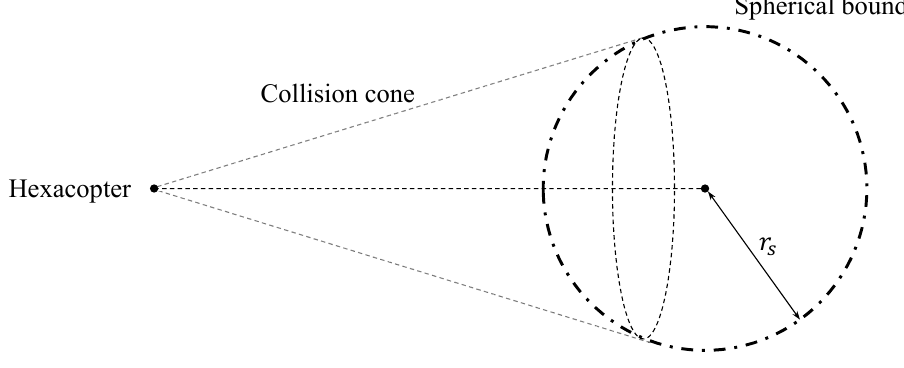
Figure 3. Constructed bounding box and collision